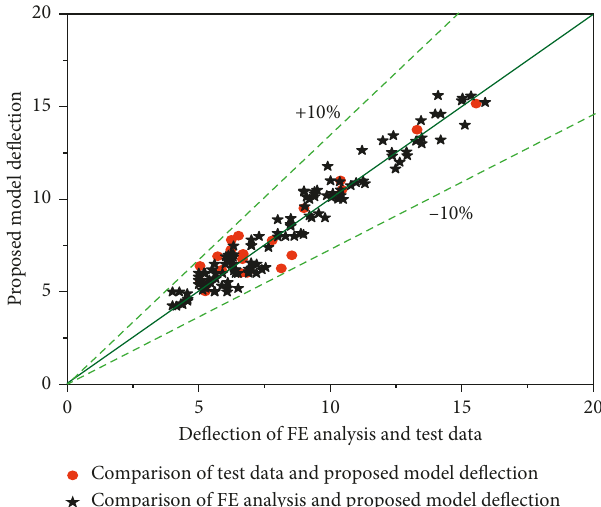
Figure 14: Overall performance of the proposed